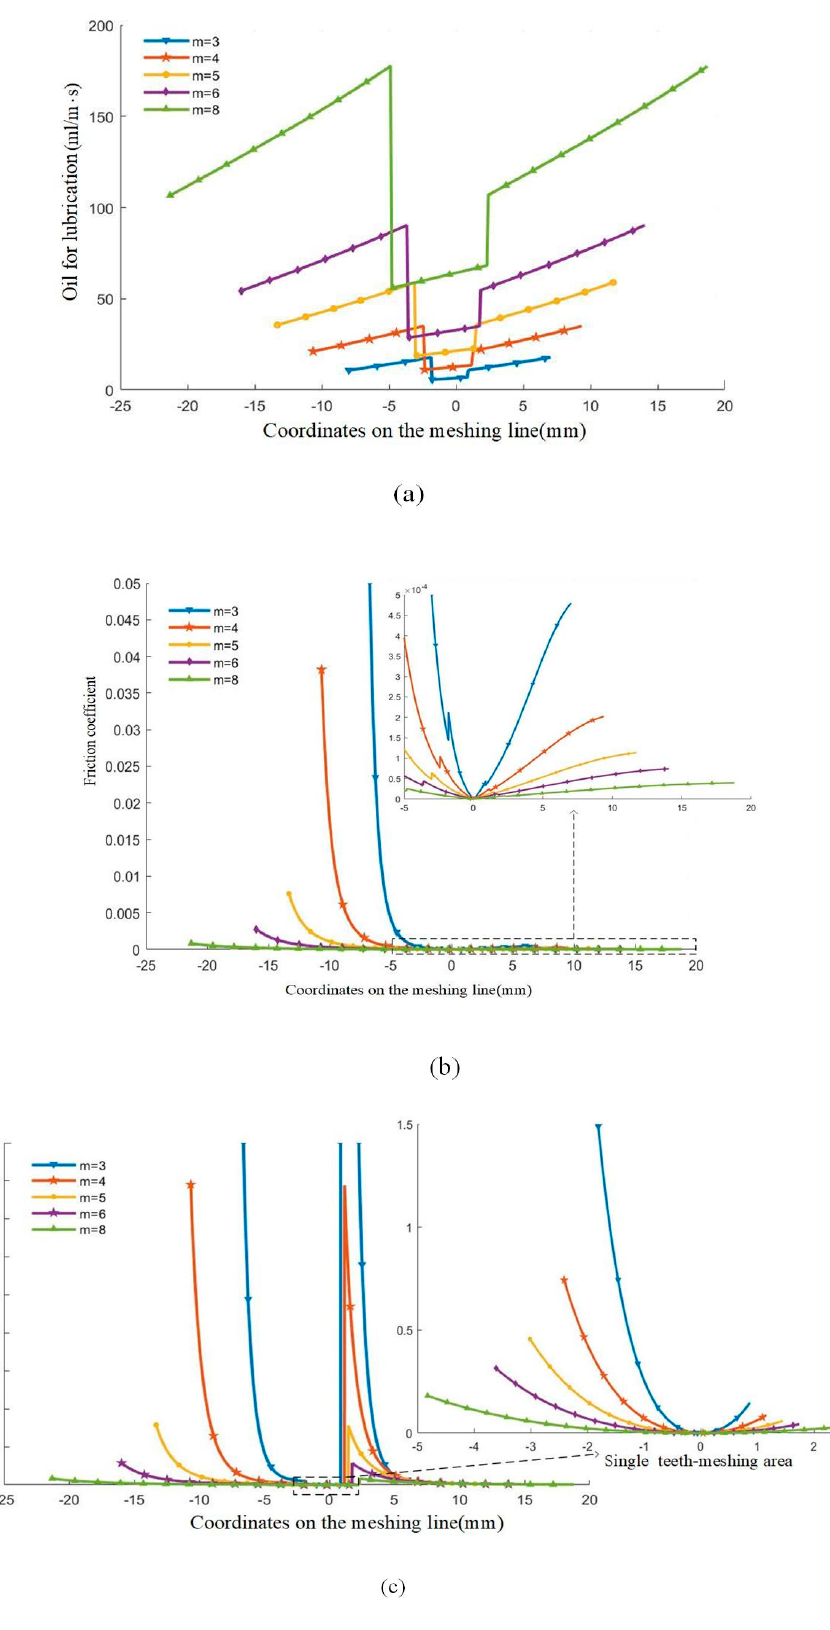
Figure 6. Oil volume for lubrication ( a ), friction coefficient ( b ), and the oil volume for cooling ( c ) under different moduli during the meshing process.